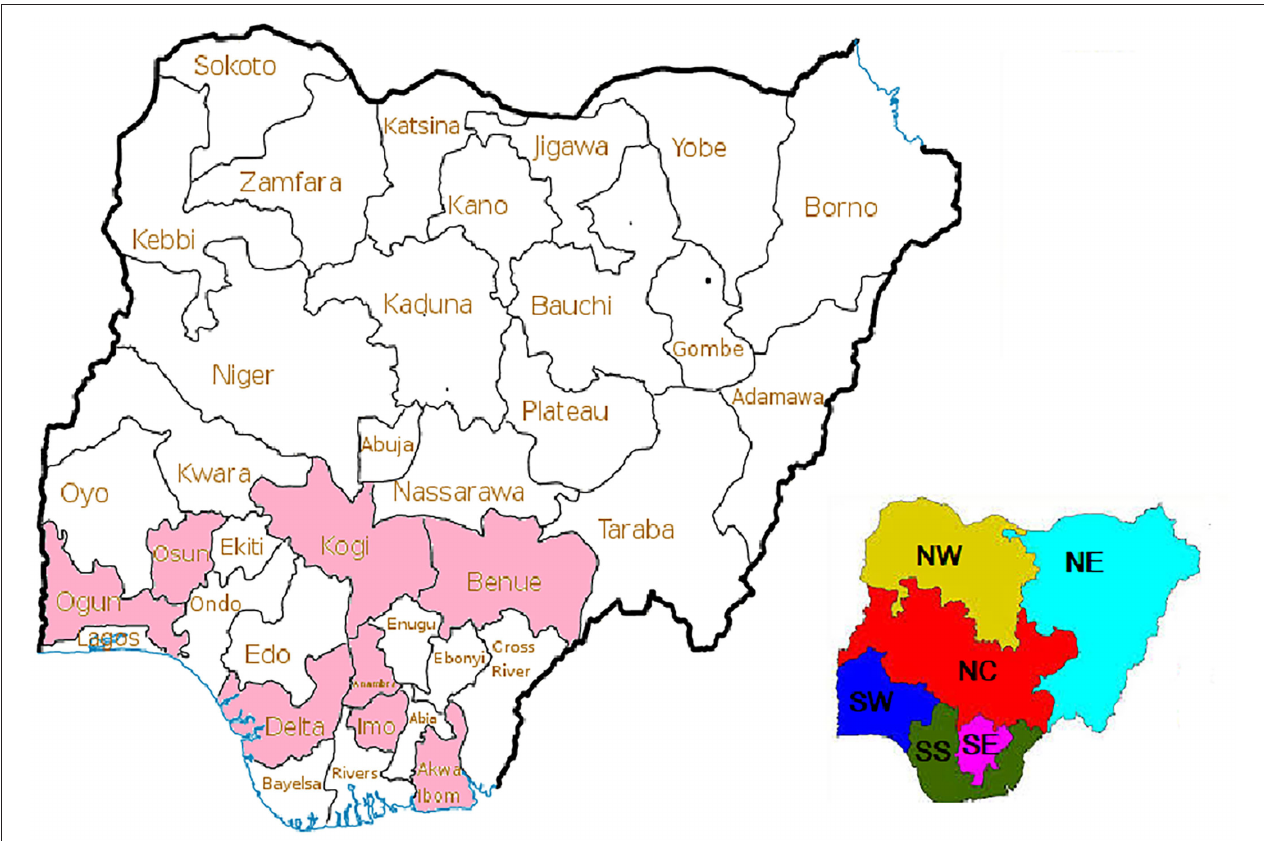
FIGURE 1 | States covered in this study with Ogun and Osun state in the South West (SW), Kogi and Benue state in the North Central (NC), Delta and Akwa Ibom in the South South (SS), and Anambra and Imo in the South East (SE)